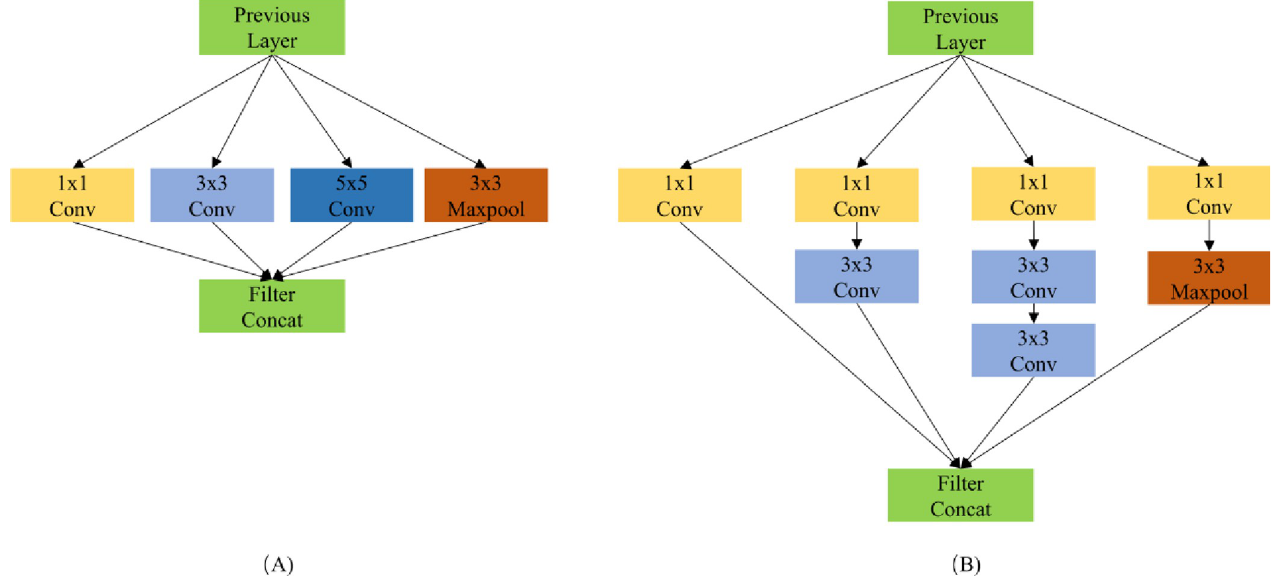
Fig 6. Schematic diagram of the inception structure. Group A represents the structure of the original inception and Group B represents the structure of the improved inception.